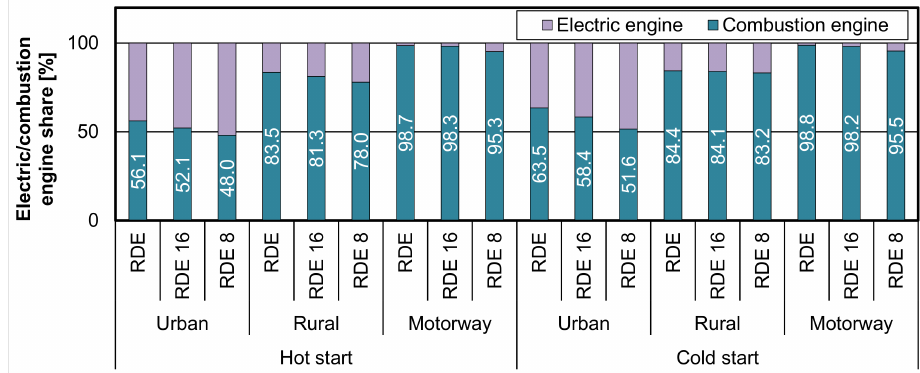
Figure 10. Share of electric/combustion engine operation in each part of RDE-Compliant, RDE 16 km and RDE 8 km tests for cold and hot